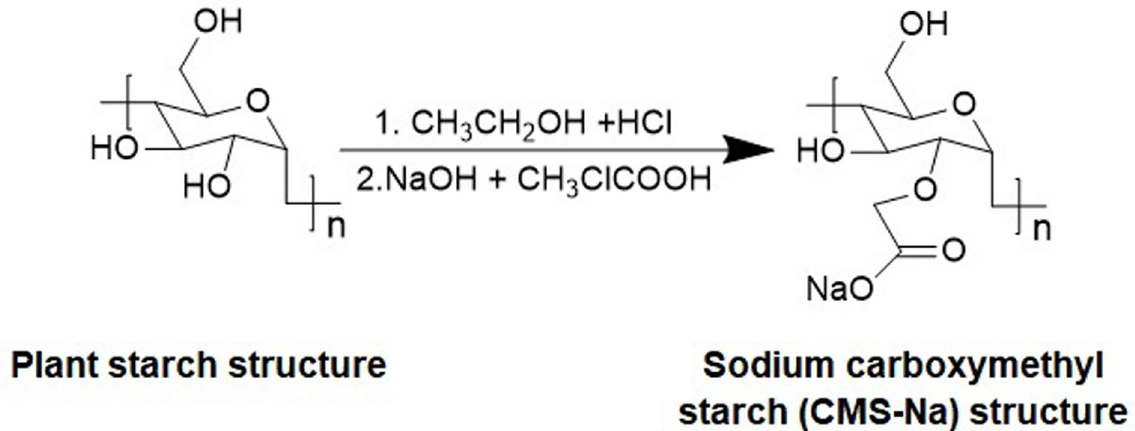
Fig 1. Sodium carboxymethyl starch (CMS-Na) is prepared by reaction from plant